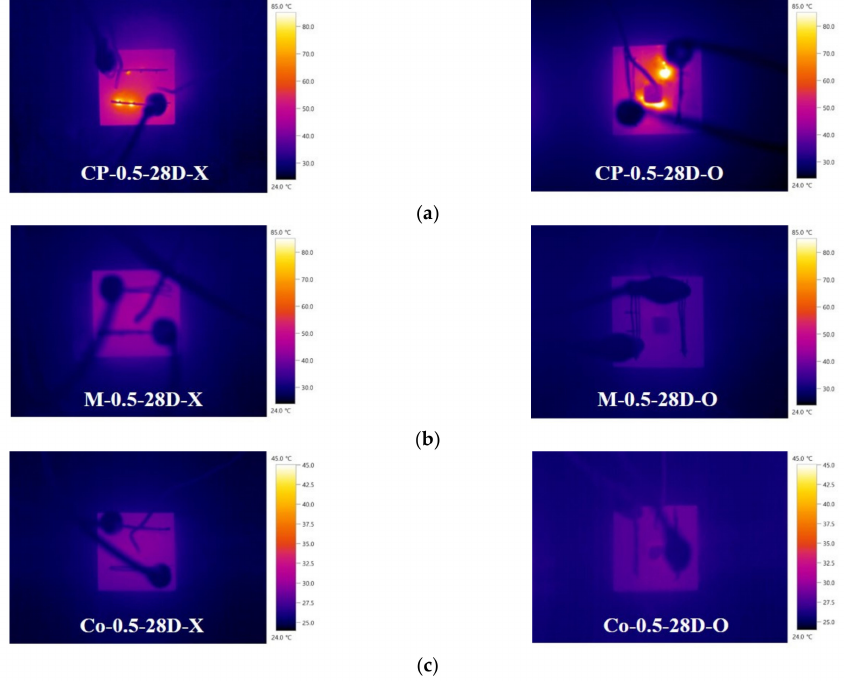
Figure 8. Thermal images at 28 curing days: ( a ) cement paste, ( b ) mortar, and ( c ) concrete (all at 60